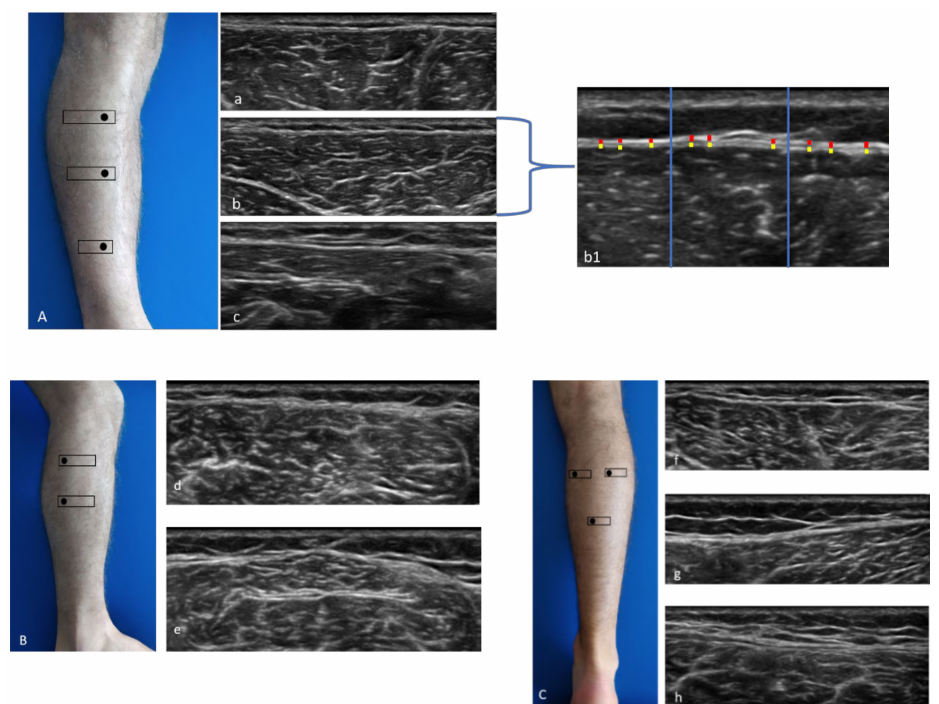
Figure 1. Ultrasound (US) images of the anterior ( A ), lateral ( B ), and posterior ( C ) compartments. Anterior compartment ( A ) at the levels Ant 1 ( a ), Ant 2 ( b ), and Ant 3 ( c ); method of measurement ( b1 ). Lateral compartment ( B ) at levels Lat 1 ( d ) and Lat 2 ( e ). Posterior compartment ( C ) at the levels Post 1 ( f ), Post 2 ( g ), and Post 3 ( h ). Probe: black rectangle. Yellow dashes: epimysial fascia; red dashes: crural